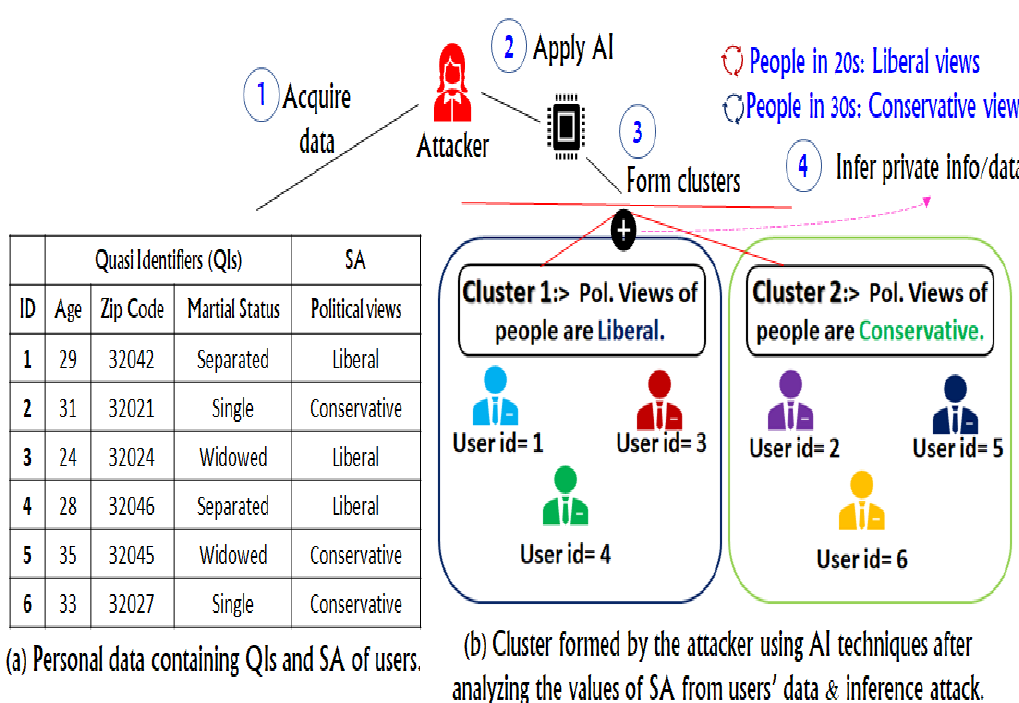
Figure 16. Group privacy problems due to SA categories-based clustering